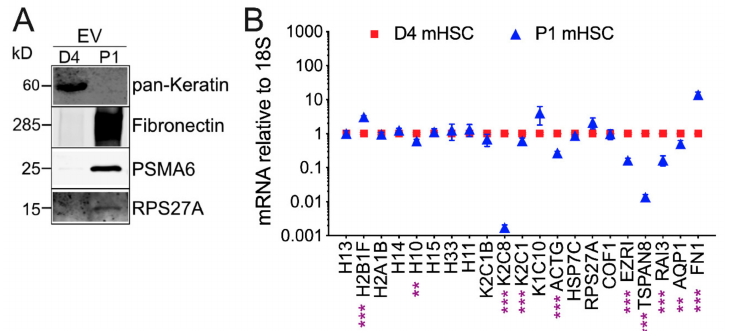
Figure 4. EV Western blot and cellular transcript levels for di ff erentially expressed EV proteins. ( A ) Western blots of EVs from D4 mHSC or P1 mHSC to verify di ff erential levels of representative proteins identified by MS. ( B ) qRT-PCR was performed on RNA from D4 or P1 mHSC using primers designed to amplify mRNA corresponding to proteins that were more highly expressed in EVs from D4 mHSC than in EVs from P1 mHSC (see Figure 3C,D). Data are mean ± S.E.M. for duplicate determinations